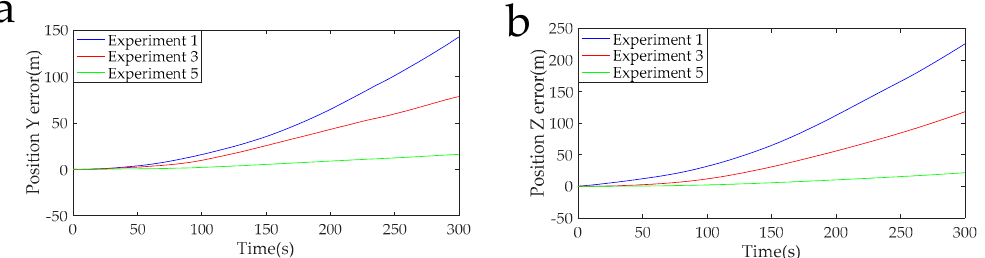
Figure 15. ( a ) Position Y error curves of the Experiments 1, 3, and 5. ( b ) Position Z error curves of the Experiments 1, 3, and 5.